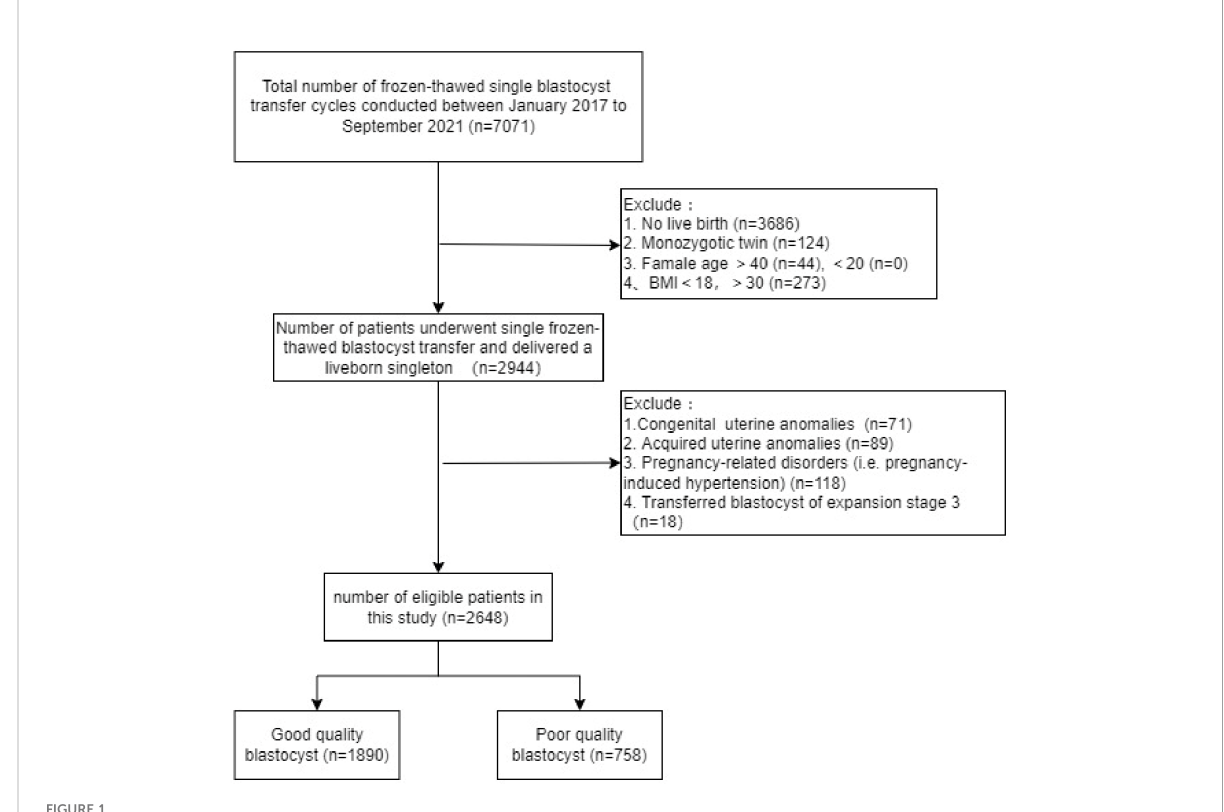
FIGURE 1 Flow chart of the